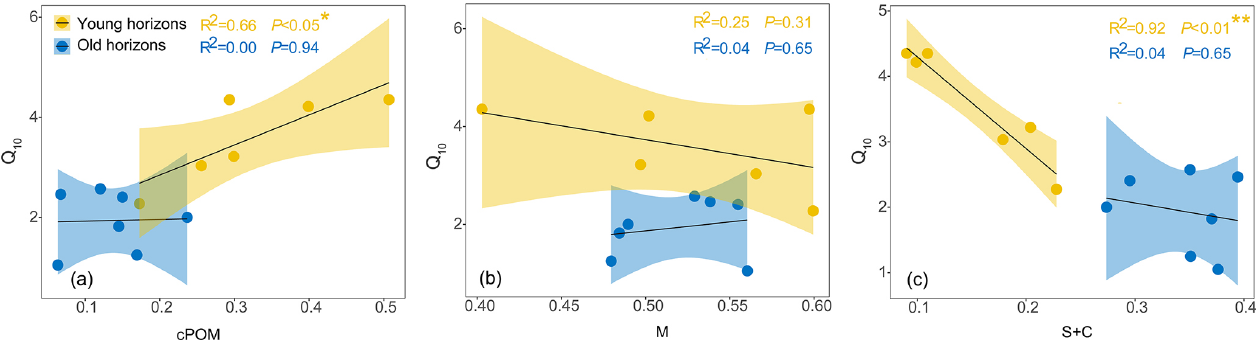
Figure 6. Relationship between SOC temperature sensitivity ( Q 10 ) and (a) coarse particulate SOC (cPOM), (b) microaggregate-associated SOC ( M ), and (c) silt- and clay-associated SOC (S + C) for relatively younger and older terrace soil horizons (Fig. 2). ∗ = P < 0.05; ∗∗ P <